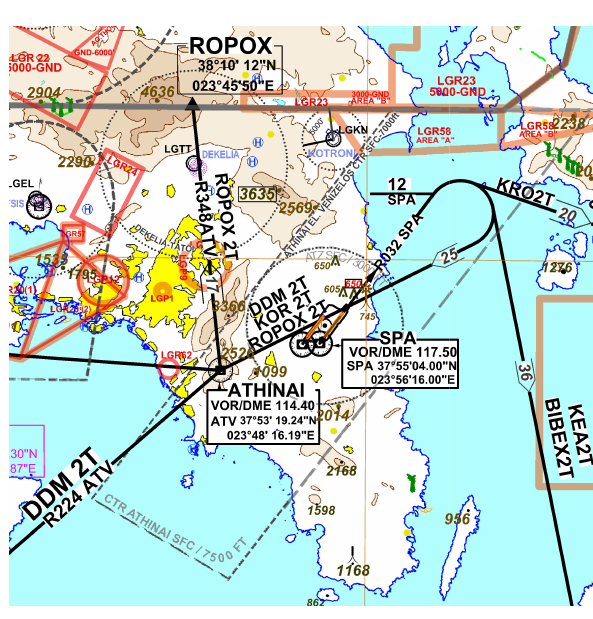
Figure 4: Tango procedure (HCAA / ANSP / AIS AIP Greece AIP GREECE - AD 2